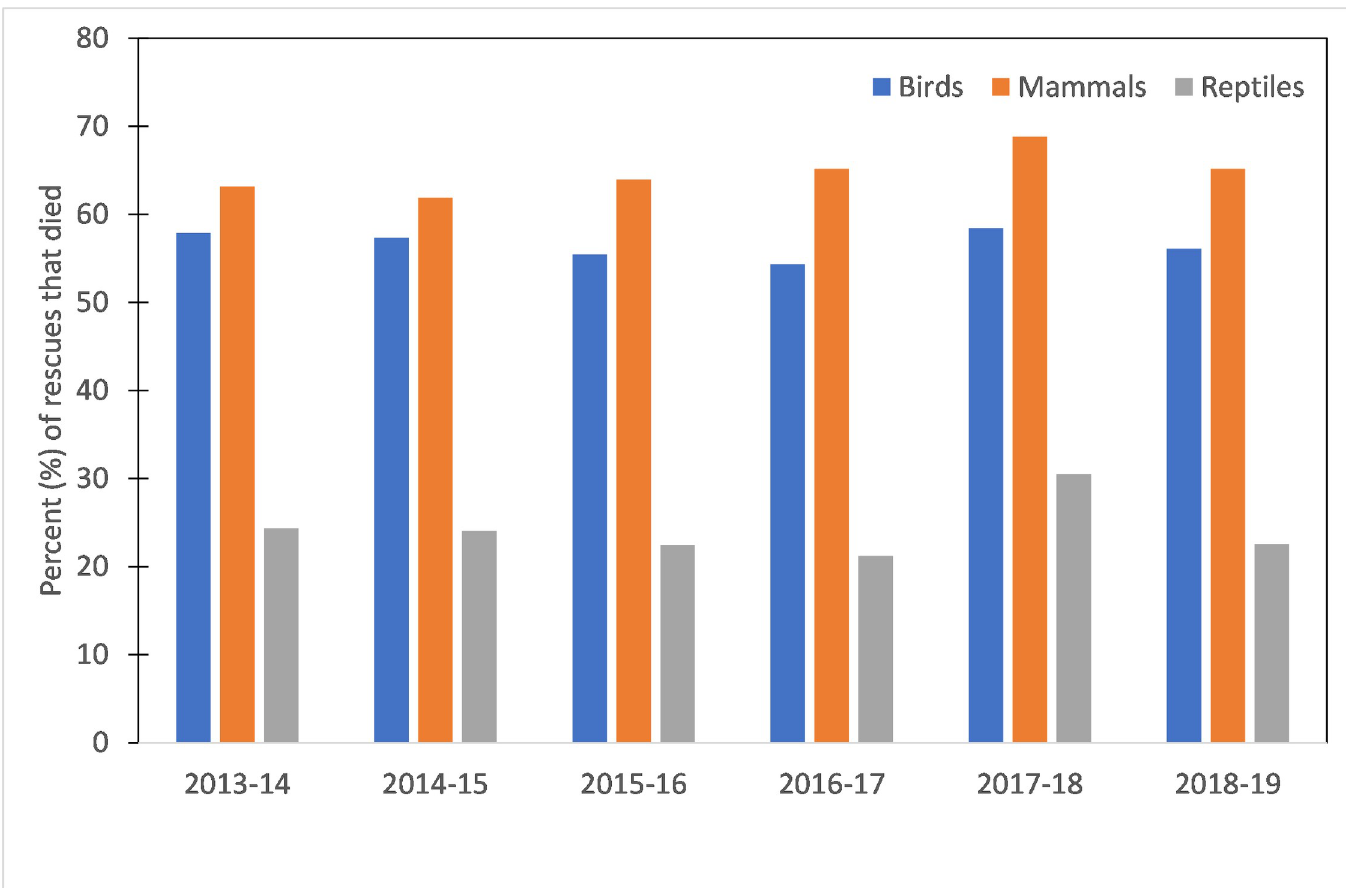
Fig 9. Percent (%) of rescues with a negative outcome for each group for each year, based on fate.